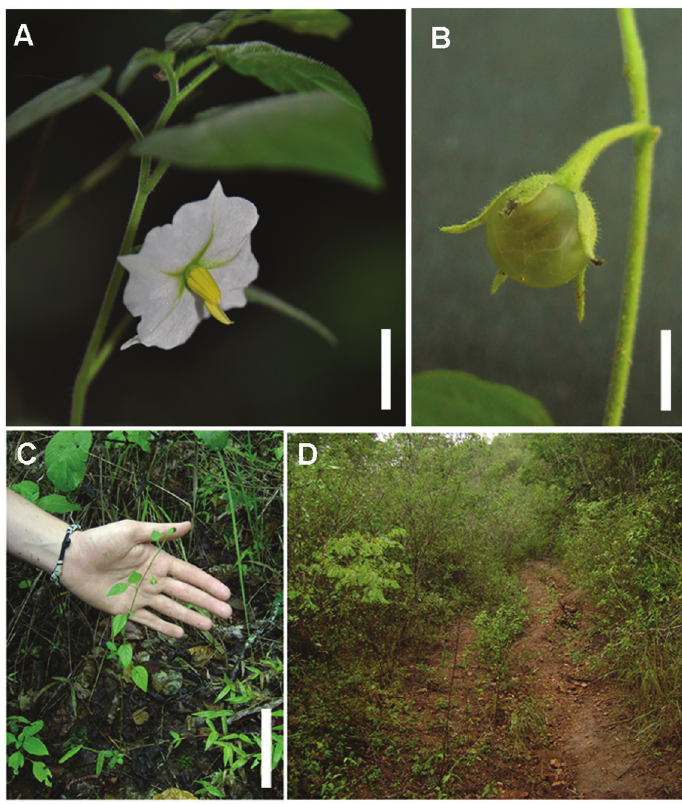
Figure 2. Solanum evolvuloides Giacomin & Stehmann. A Flower, opened during the morning in a cultivated seedling B Fruit, with a semi-transparent exocarp C Habit D Habitat in a shrubby caatinga formation. Scale bars A= 1.5 cm, B= 1 cm; C = 10 cm. All from Giacomin 974 (BHCB; type